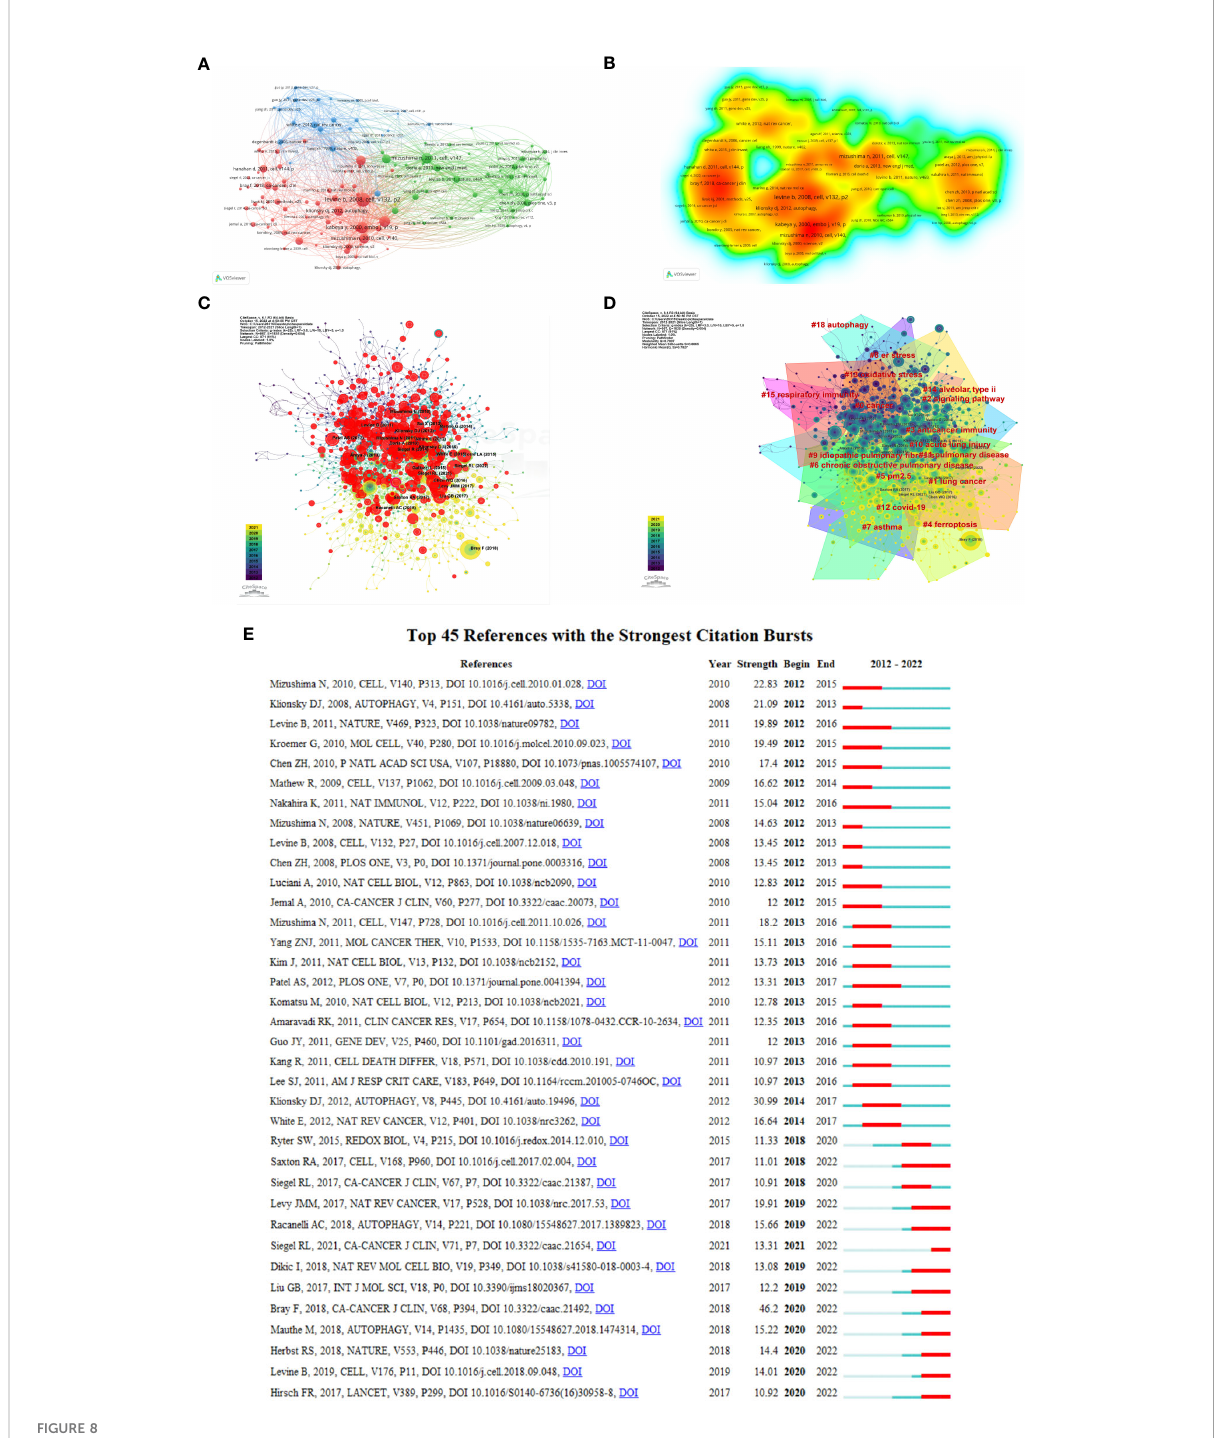
FIGURE 8 Visualization of co-cited references on autophagy research in lung disease. (A) Reference co-citation network. Circles are co-cited literature. (B) Co-cited reference density visualization. (C) Network visualization diagram of cited references. (D) The clustered network map of lung disease autophagy-related co-cited references. (E) The 45 references having the highest citation